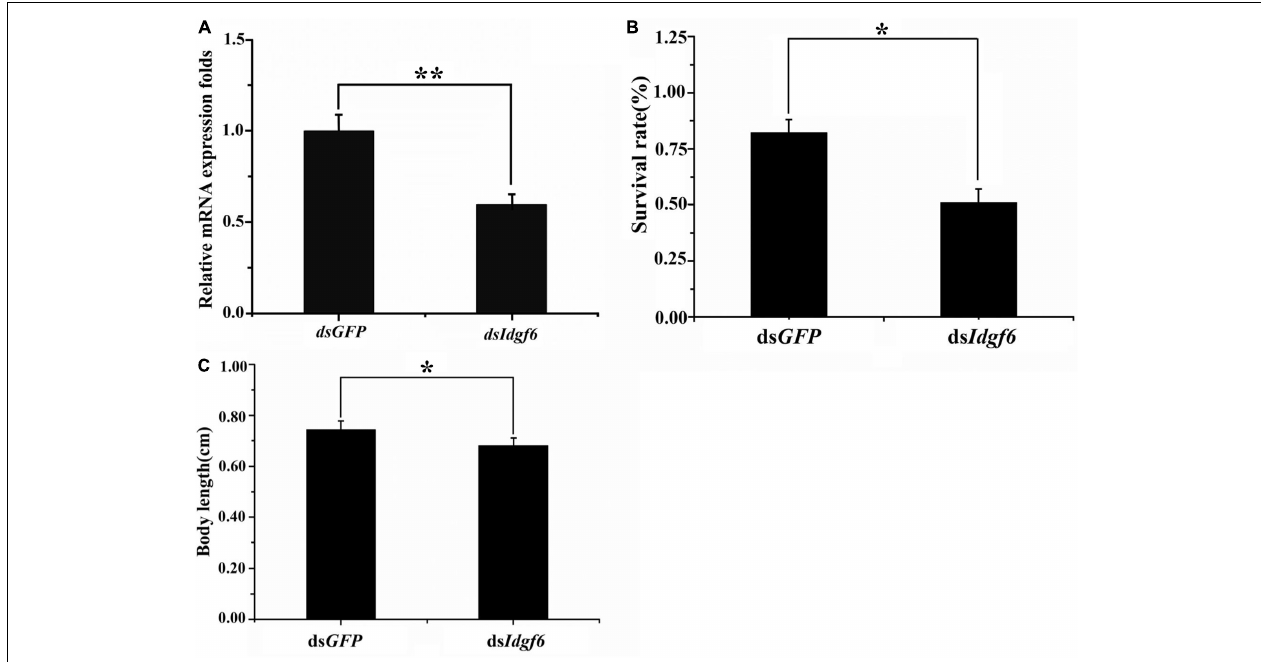
FIGURE 4 | Effect of silencing Idgf6 in B. correcta . (A) The relative expression level of Idgf6 after feeding ds Idgf6 . (B) Larvae survival rate after exposure to dsRNA. (C) Larval body sizes after exposure to dsRNA. All the fruit flies in the functional study shown in Figure 4 were 5-day-old 3rd early instar larvae exposed to dsRNA at a concentration of 1000 ng/ µ l for 96 h at 25 ◦ C. Five replicates were conducted and the data were presented as mean ± SE. **indicates a statistically significant difference in Idgf6 mRNA expression between the ds Idgf6 group and the control ds GFP groups ( t -tests: P < 0.01). *indicates a statistically significant difference in survival and body length between the ds Idgf6 group and the control ds GFP group ( t -test: P < 0.05).